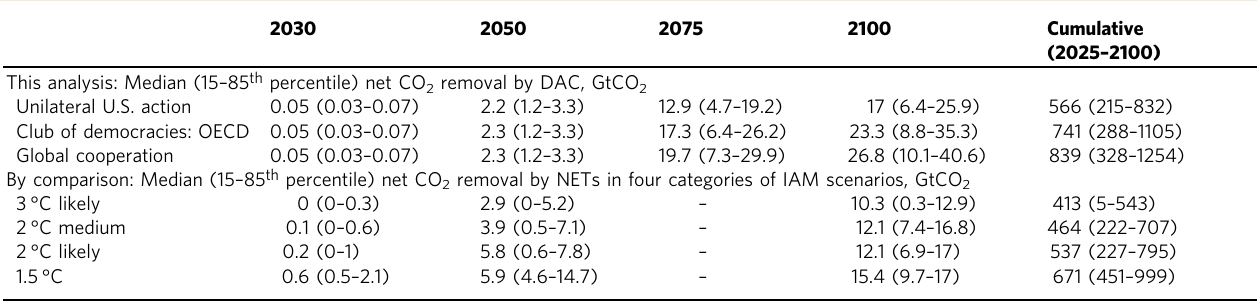
Table 2 Net CO 2 removal compared to published IAM deployment of